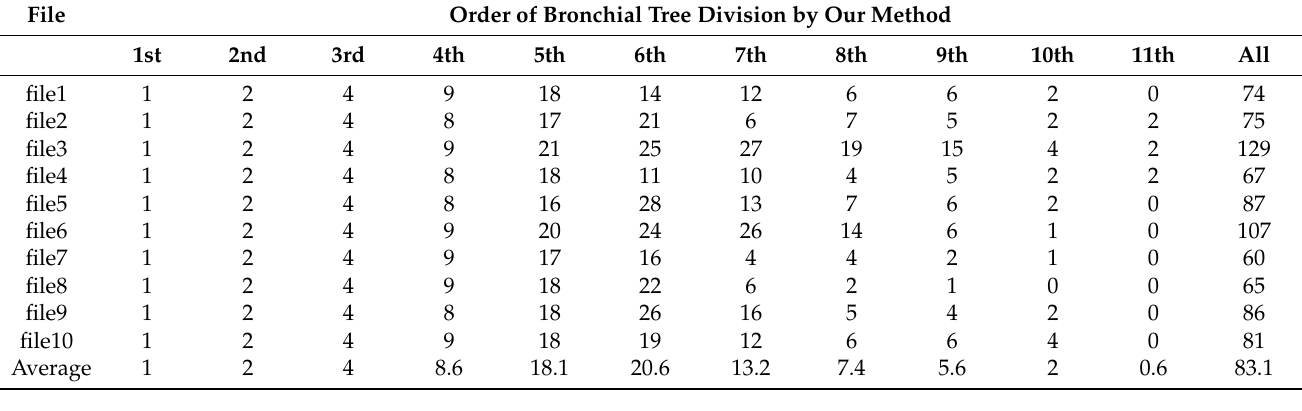
Table 1. Topological algebra and quantity detected by our method.